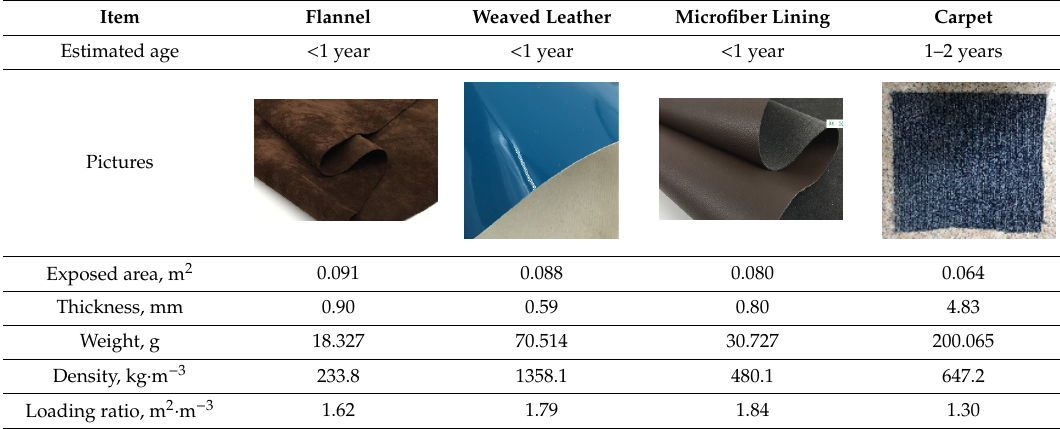
Table 2. Material information on the specimens of the four synthetic fibers. Flannel Weaved Leather Microfiber Lining Carpet Estimated